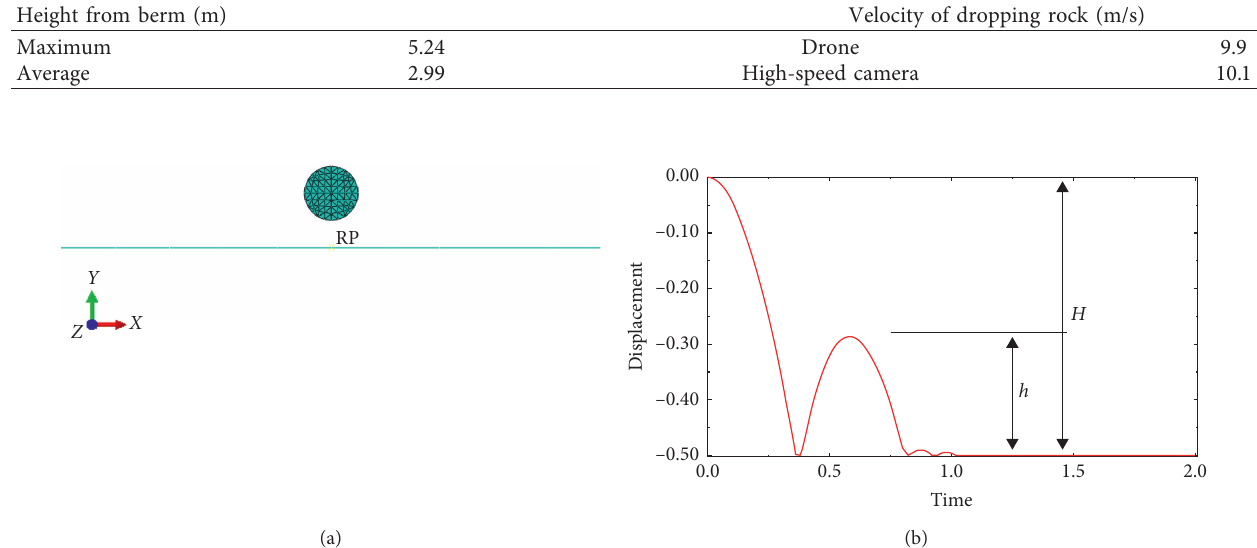
Table 3: Rock-dropping test results.